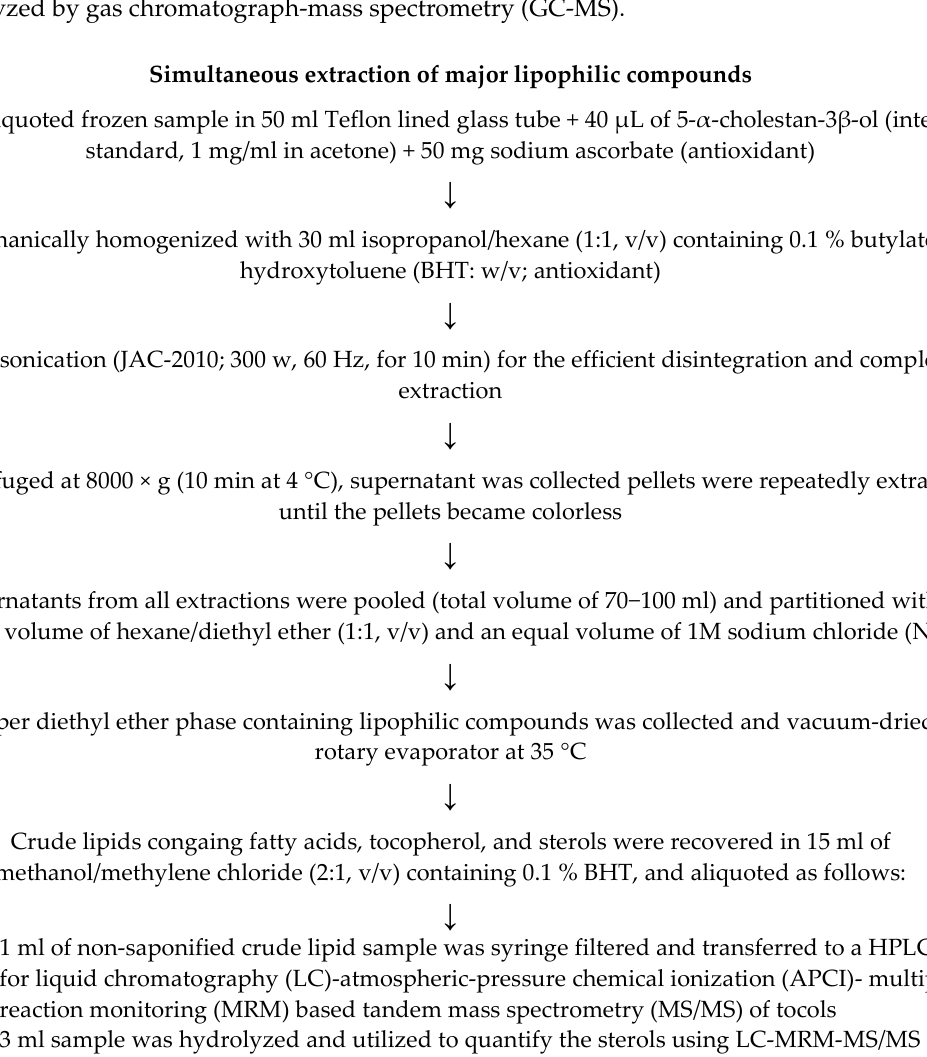
Figure 1. Method for the simultaneous extraction of major lipophilic compounds.